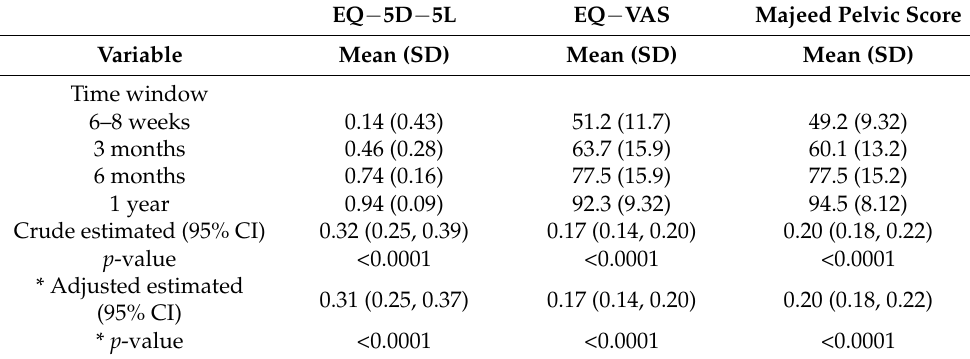
Table 3. Distribution of outcomes among time windows.